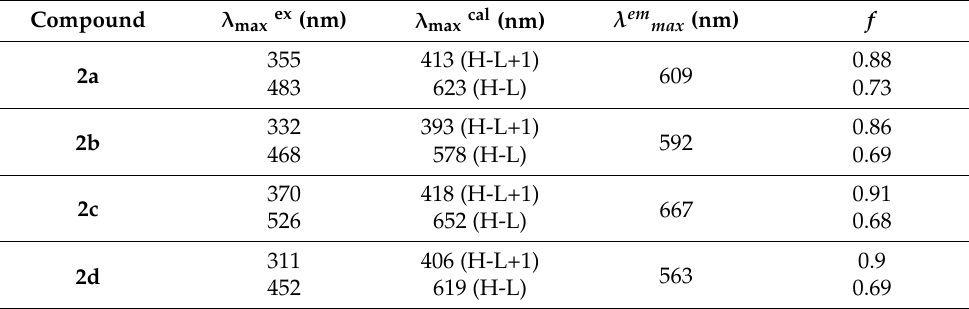
Table 2. Theoretical properties and maximum of experimental absorption and emission of investi ‐ gated compounds: λ max —maximum wavelength of absorption; λ em max —maximum wavelength of emission; ex —experimental; cal —calculated; f —oscillator strength.